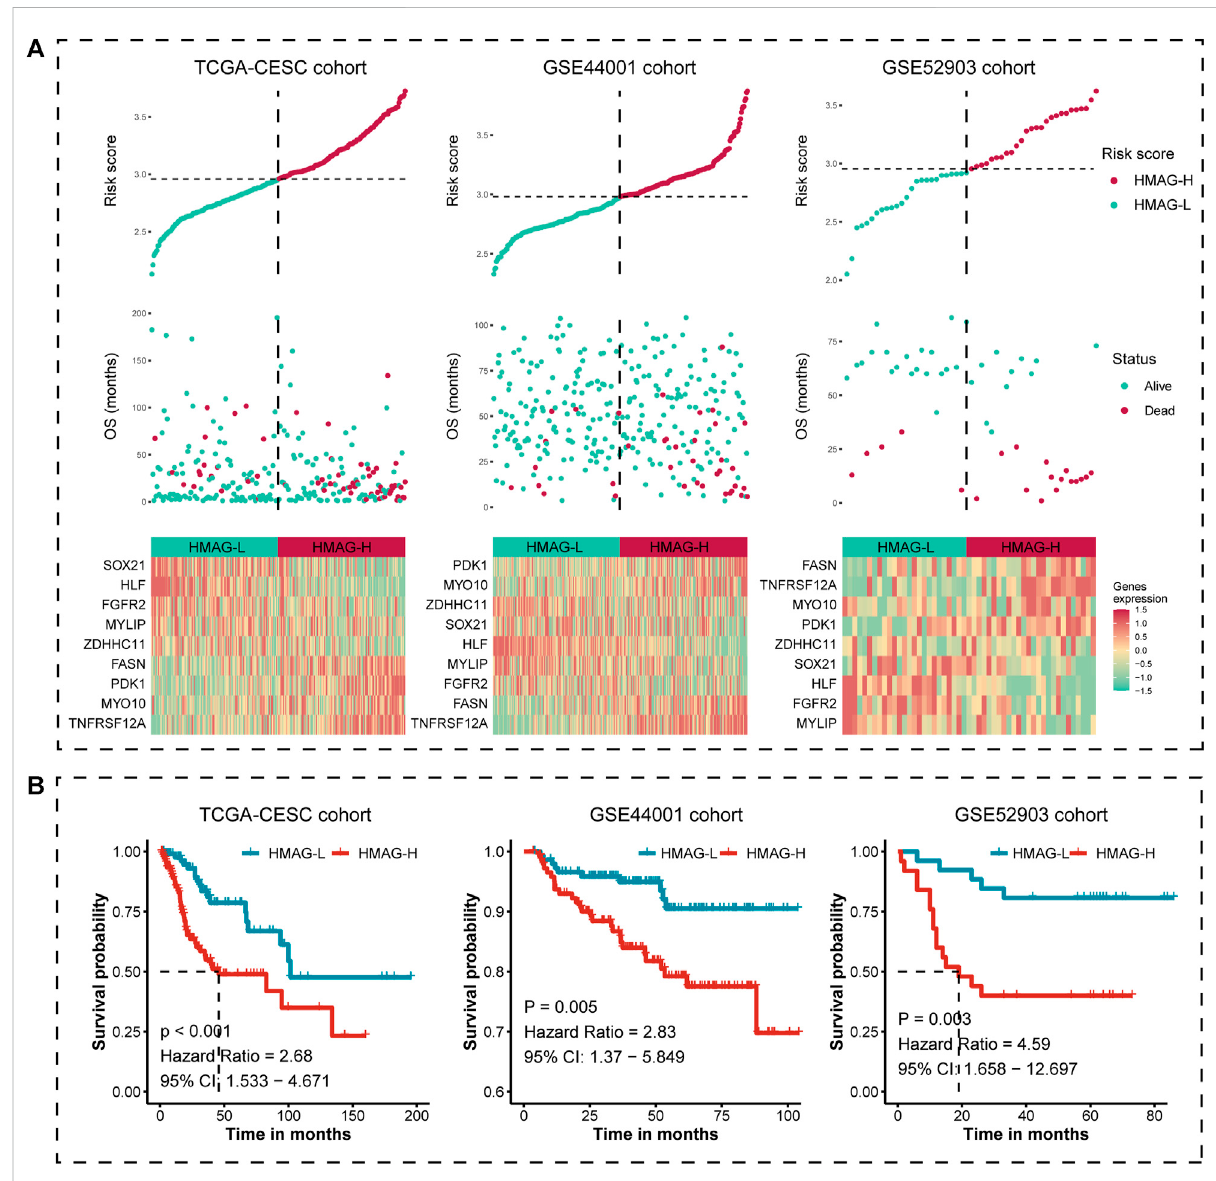
FIGURE 3 Risk map and K-M plot for TCGA-CESC, GSE44001, and GSE52903 cohorts. (A) Risk score distribution (upper), clinical outcome distribution (middle), and gene expression distribution (bottom) for TCGA-CESC, GSE44001, and GSE52903 cohorts. (B) K-M plot of the HMAG-L score and HMAG-H score subgroups for TCGA-CESC, GSE44001, and GSE52903